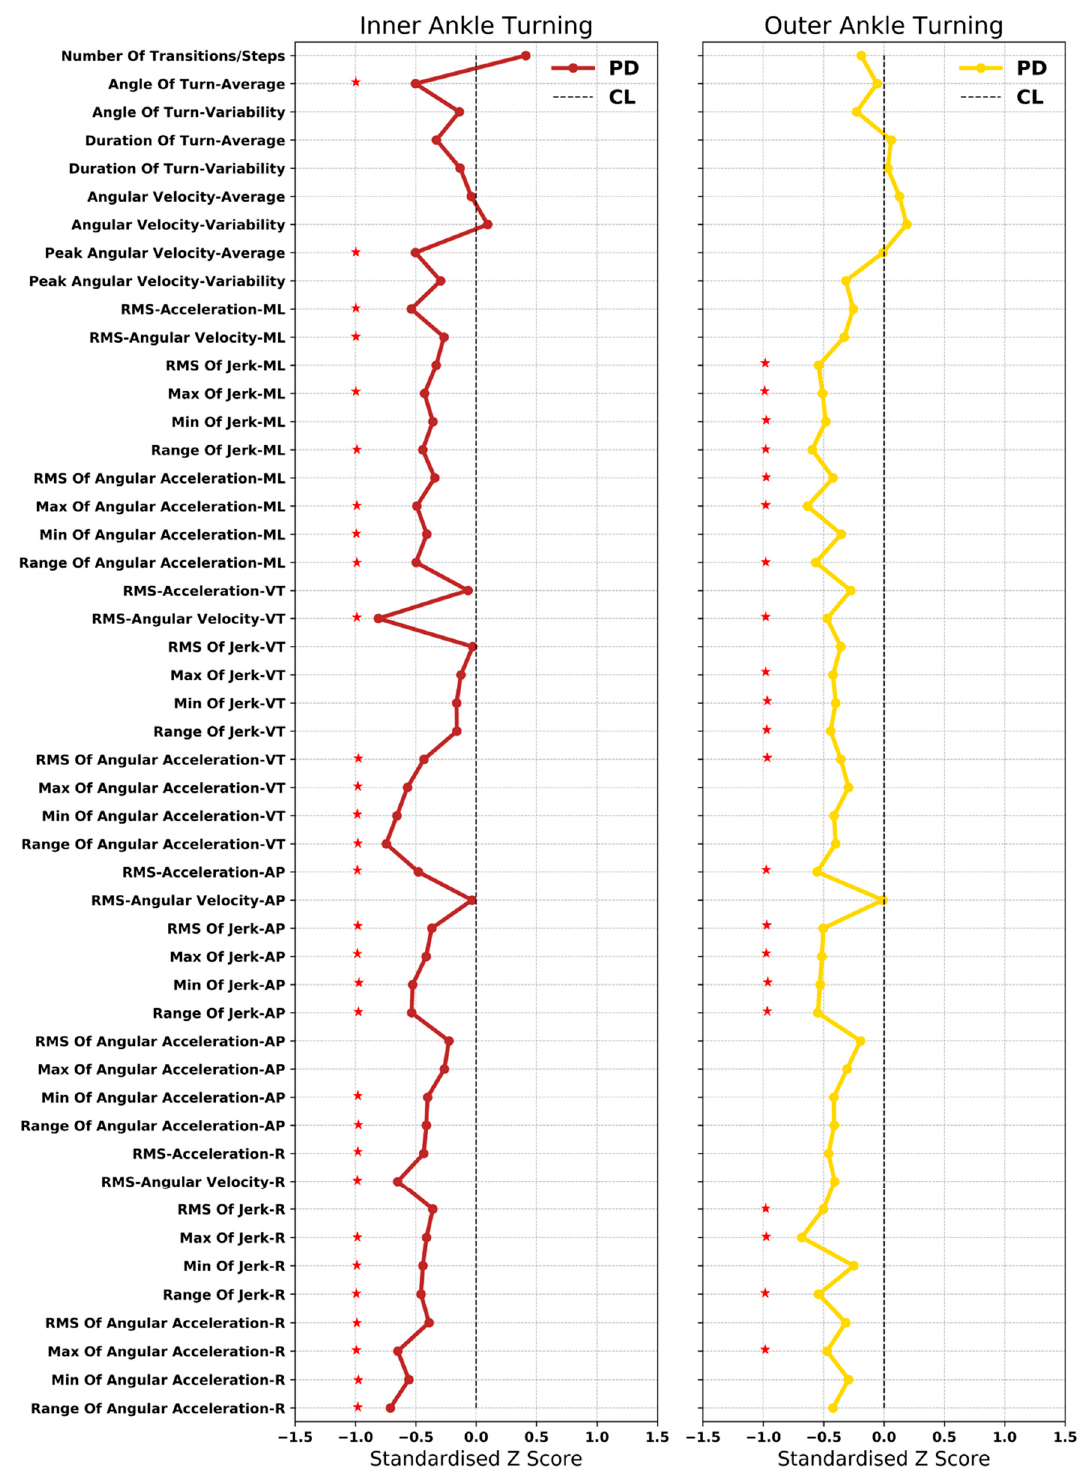
Figure 4. Turning characteristics extracted from the lower body for PD and CL (red star indicates significant group differences p < 0.05).